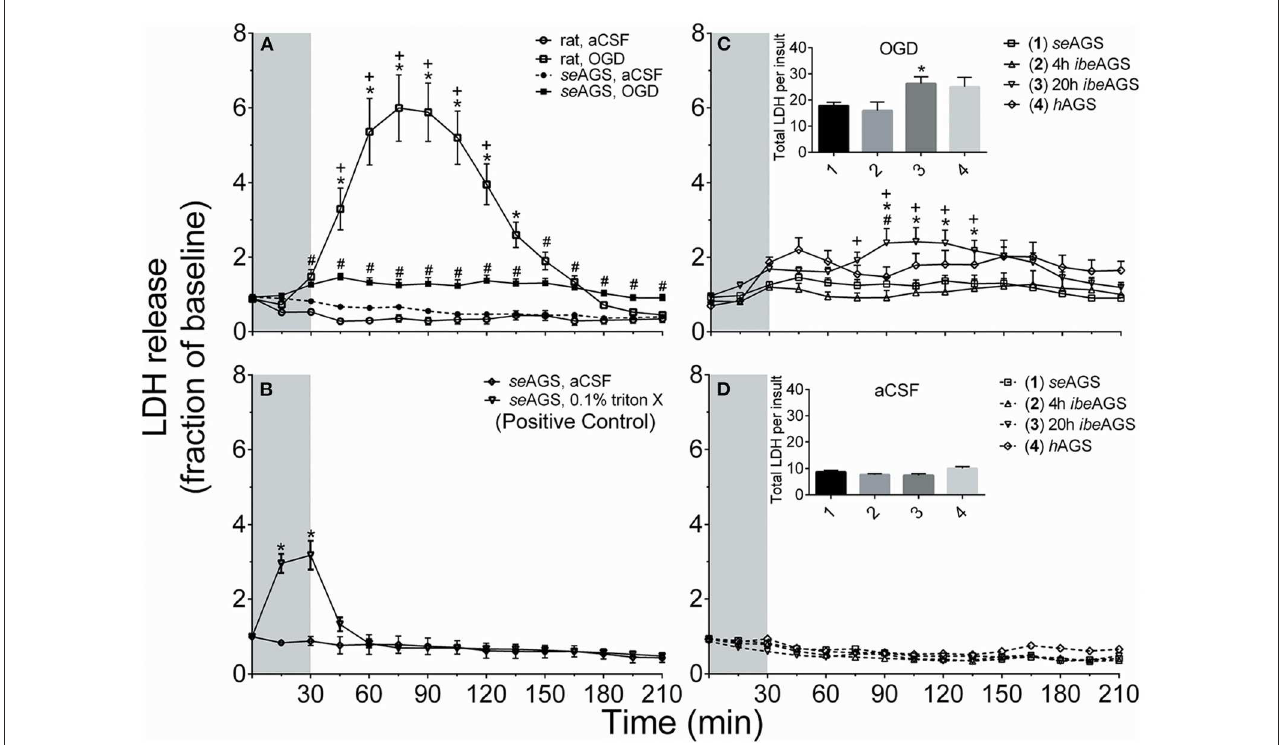
FIGURE8 AGS brain tolerates OGD better than rat regardless of hibernation state or season. Cell death was measured from LDH released into the perfusion fluid in acute hippocampal slices from rat and euthermic AGS during the summer season (seAGS), during hibernation torpor (hAGS) and during early arousal (4h ibeAGS) and late arousal (20h ibeAGS), 4 and 20h after initial handling to induce arousal. (A) LDH in perfusates increased in rat hippocampal slices exposed to OGD (rat, OGD), but not in rat slices exposed to artificial cerebral spinal fluid (aCSF) (rat, aCSF), nor in slices harvested from summer euthermic AGS and exposed to aCSF (seAGS, aCSF). A small amount of cell death is noted in slices collected from seAGS and exposed to OGD (seAGS, OGD). * p < 0.05 rat aCSF vs. rat OGD, + p < 0.05 rat OGD vs. seAGS OGD, # p < 0.05 seAGS aCSF vs. seAGS OGD. (B) As a positive control TritonX increased LDH release in seAGS slices (* p < 0.05 0.1% TritonX vs. aCSF). (C) AGS hippocampal slices are most vulnerable to OGD when collected from AGS 20h into an interbout arousal (20h ibeAGS). Insert shows the sum of LDH in perfusates collected 15–210min from onset of OGD. * p < 0.05 seAGS vs. 20h ibeAGS, + p < 0.05 4h ibeAGS vs. 20h ibeAGS, # p < 0.05 hAGS vs. 20h ibeAGS, t -test with Bonferroni correction. (D) Exposure of slices from the same groups of animals as in (C) to aCSF has no effect on LDH release. Gray bar indicates 30min treatment period. Data shown are means ± SEM, n =